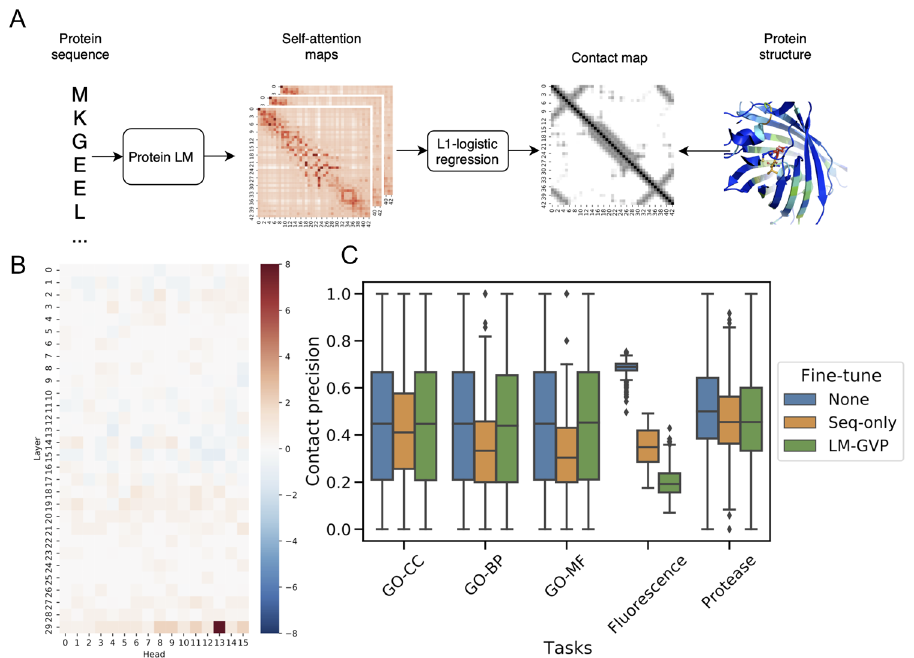
Figure 4. Predicting protein contact maps with self-attention maps from protein LMs. ( A ) Schematic view showing how self-attention maps from protein LMs can be used to predict contact maps. ( B ) Weights from L1-logistic regression trained to predict residue contacts. ( C ) Box plot showing the distribution of contact map prediction precision from self-attention maps in the protein LM before and after different fine-tuning